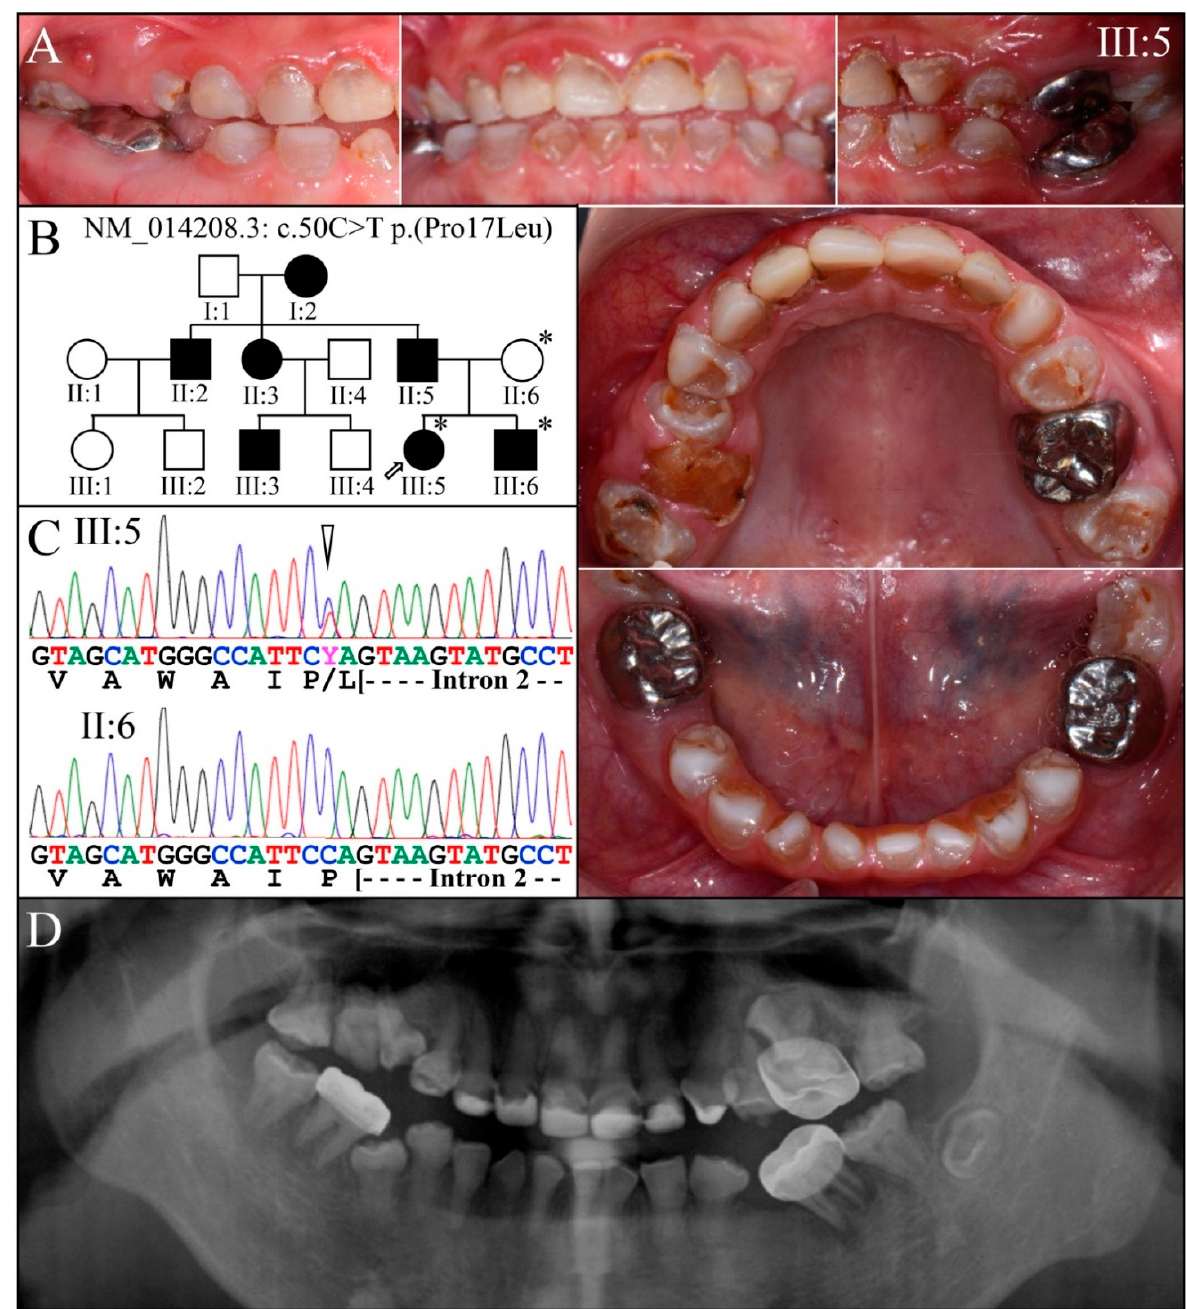
Figure 1. Family 1 from Taiwan. ( A ): The dental phenotype of the proband (III:5) showed amber- brown discoloration, opalescent teeth in permanent dentition. Photographs of the buccal surfaces (top) showed discoloration of the mandibular primary incisors prior to their restoration. ( B ): Three- generation pedigree of the family showing an autosomal dominant pattern of inheritance. ( C ): Sanger sequence chromatograms show the disease-causing mutation near the 5 ′ end of single DSPP allele (NM_014208.3:c.50C>T, NP_055023.2: p.Pro17Leu). The "Y" abbreviation at the heterozygous mutated position (arrowhead) indicates the presence of a pyrimidine (C or T). ( D ): The panorex radiograph of III:5 taken at age 12-years 7-months showed complete obliteration of the root canals, bulbous molar crowns, and dental abscesses of primary first molars. Key : * denotes enrolled participants.